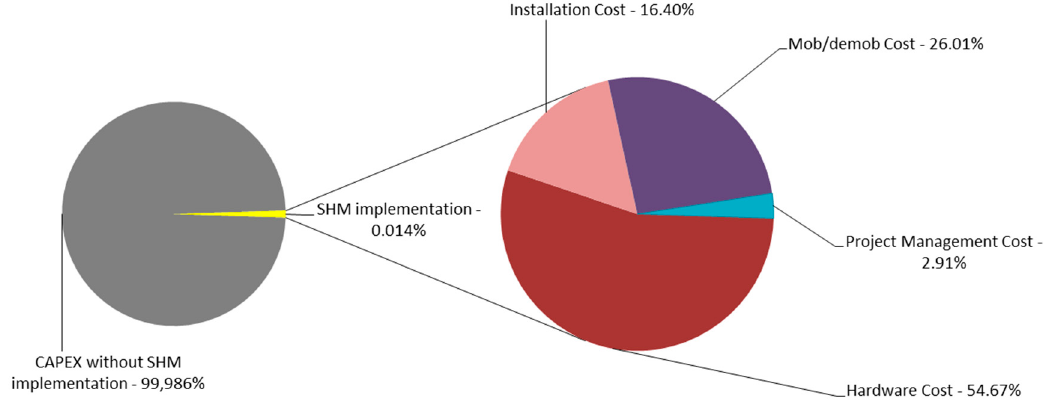
Energies 2019 , 12 , x